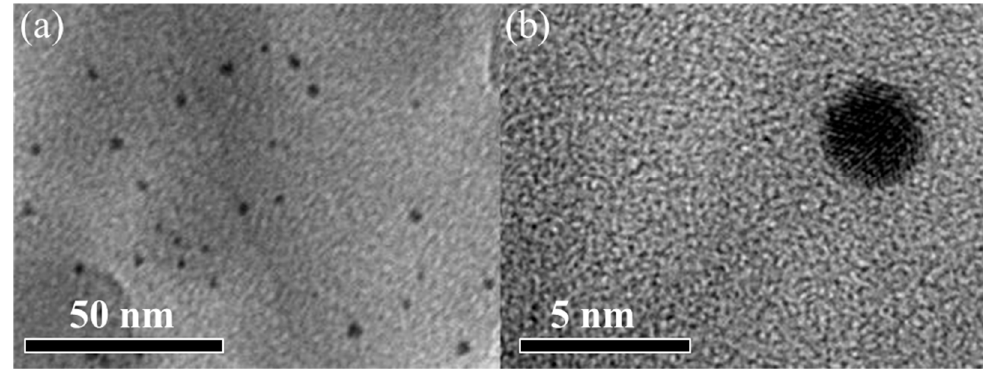
Figure 2. ( a ) Low and ( b ) high magnification STEM image of 0.05% Au/ β -CD-CN.